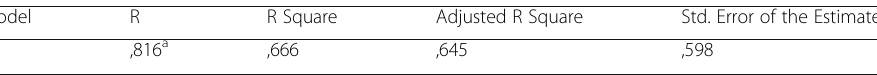
Table 23 Model Summary R5